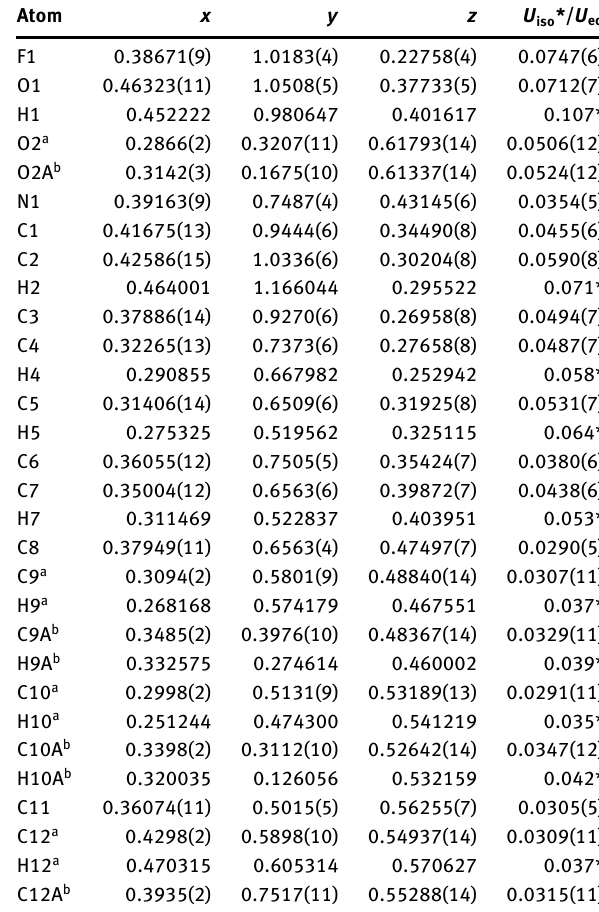
Table 2: Fractional atomic coordinates and isotropic or